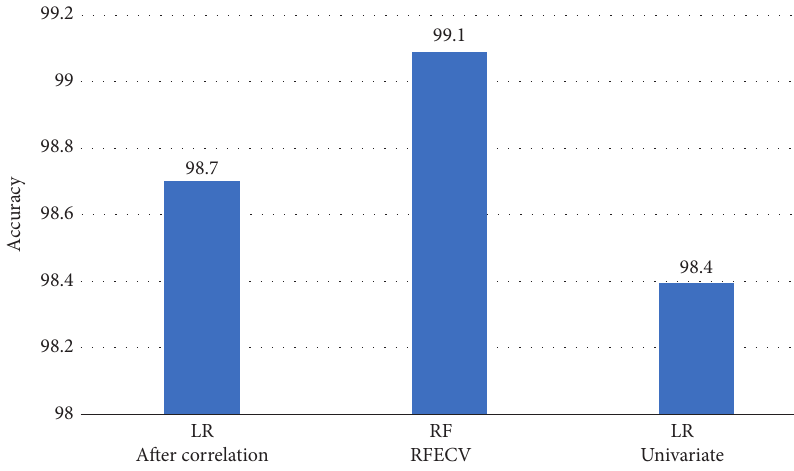
Figure 6: The best models of the unseen data results.